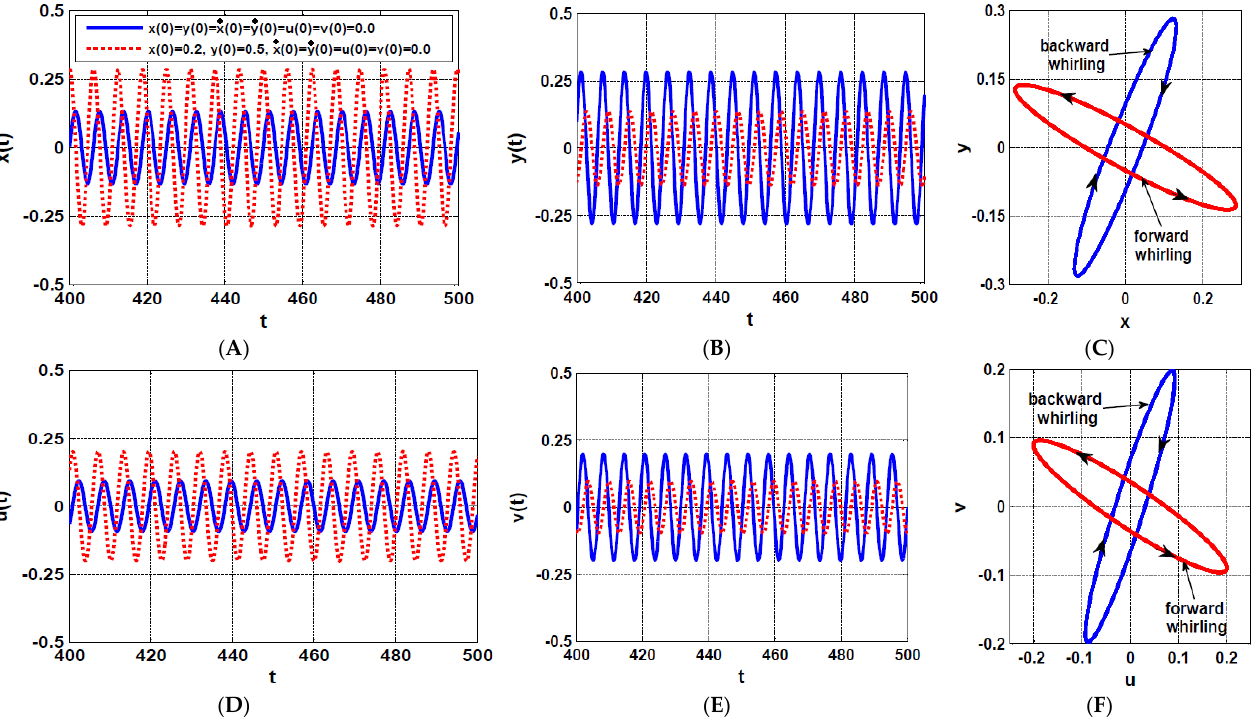
Figure 6. The rotor system steady-state time-response according to Figure 5A,B when 𝜎 = 0 : ( A , B ) temporal oscillation in 𝑋 and 𝑌 directions, respectively, ( D , E ) temporal oscillations of the U-IRC and V-IRC, respectively, ( C , F ) the corresponding periodic orbits.